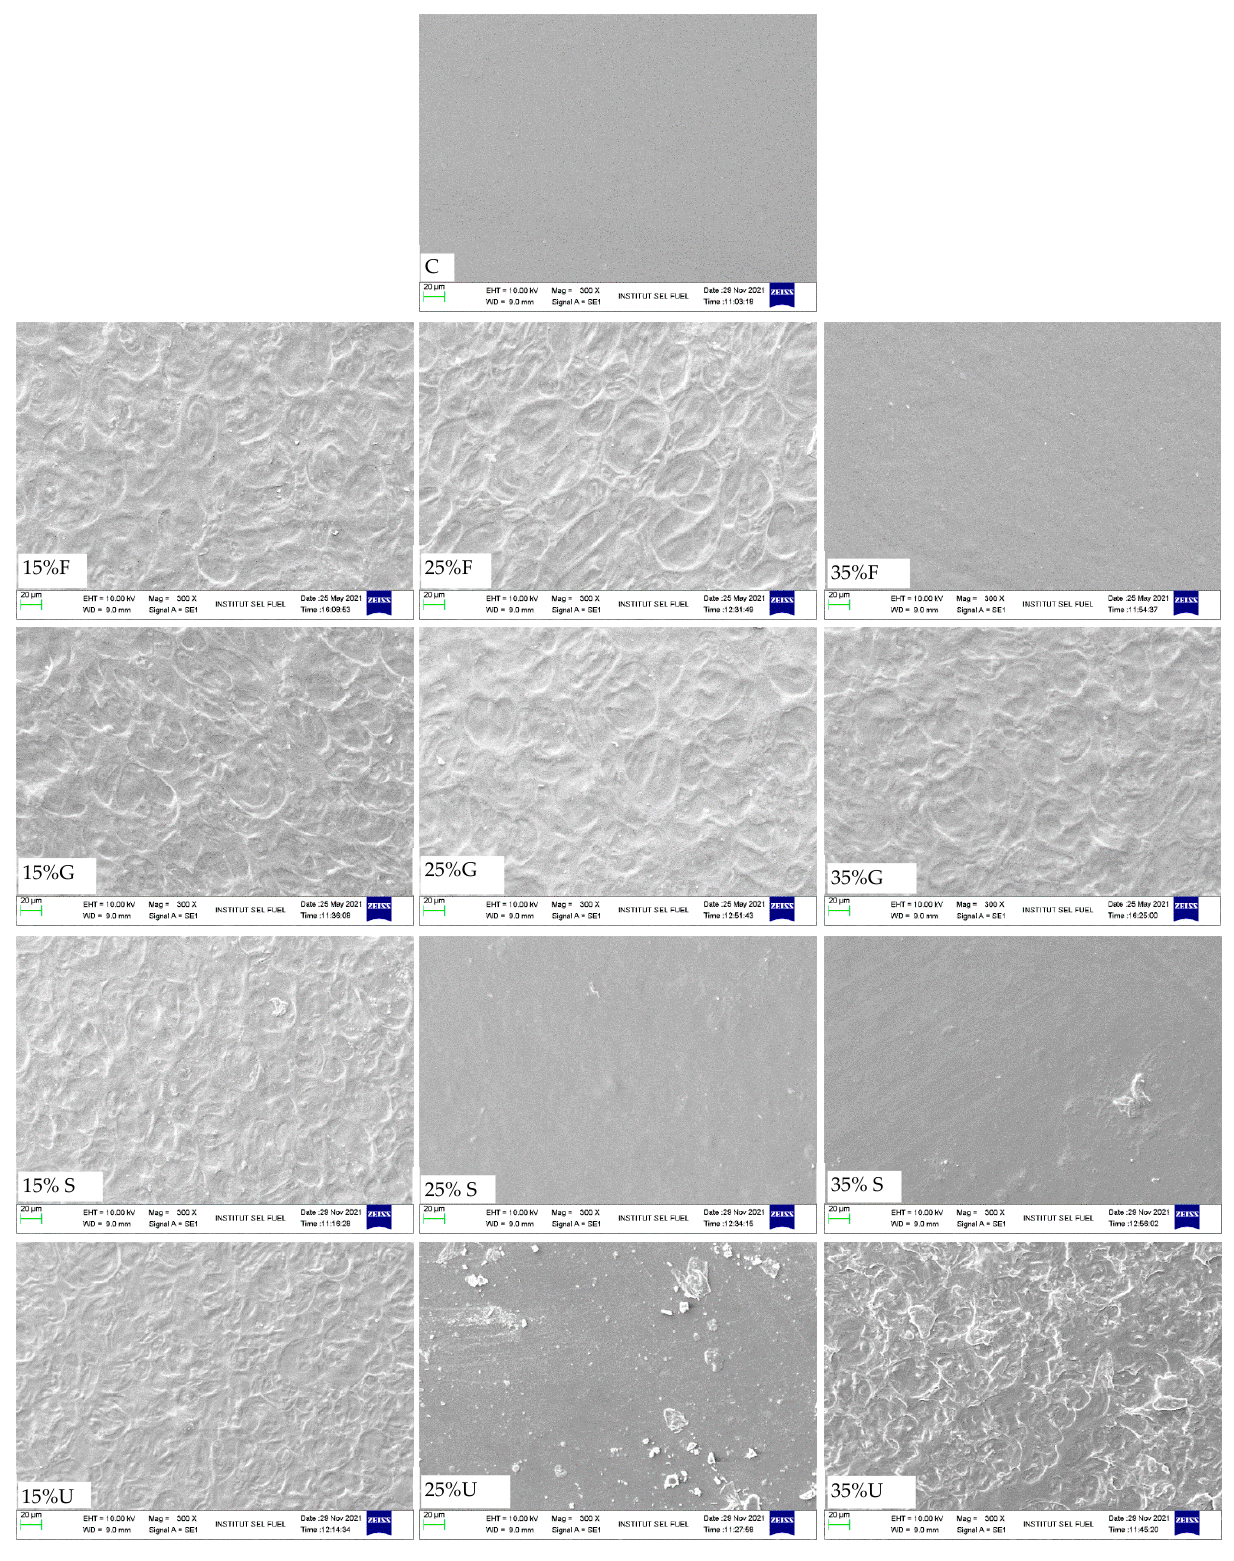
Figure 4. SEM images of wheat starch films with various plasticizer types at different concentra- tions.